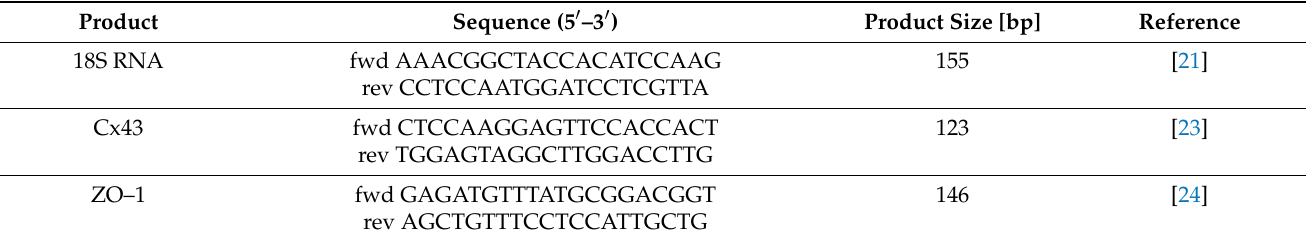
Table 1. Primer pairs used for quantitative real-time